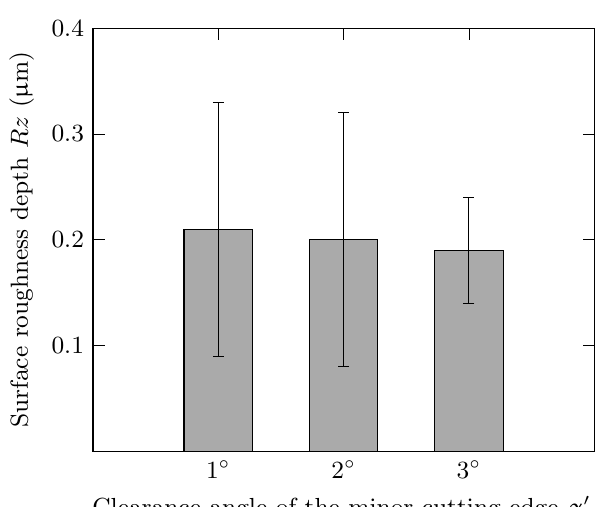
Figure 9. Surface roughness depth Rz for different clearance angles α (cid:48) o of the minor cutting edge ( v c = 250m/min, f z = 0.015mm, a p = 0.25mm, a e = 0.5mm, γ (cid:48) o = 0 ◦